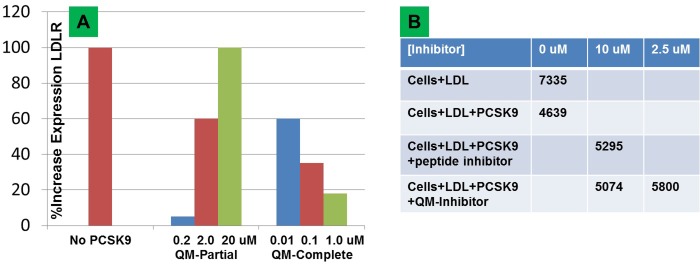
PCSK9 cellular assays.Addition of PCSK9 to HepG cells causes LDLR internalization. LDLR cell surface expression (A) is normalized by assigning 0% and 100% to the experiment with added and no PCSK9 respectively. Using this scale, the compound with the partial QM linker has an EC50 between 0.2–2.0 μM with a typical dose-response curve. The compound with a delocalization linker has an EC50 < 10 nM with an aberrant inverse dose-response curve (observed with anti-cancer agents, see discussion) due to π-π stacking. We tested the compound with a linker that supports delocalization (B) in fluorescently labeled LDL uptake assays with HepG cells. When the compound blocks PCSK9, more LDL particles are internalized inside the cells and the fluorescence remains after a wash. We used a peptide inhibitor known to block PCSK9 with 1 μM affinity as a positive control. The fluorescence of the cells after application of labeled LDL is 7335, but reduced to 4639 with application of PCSK9 and partially restored to 5295 when 10 μM of peptide is added. The complete inhibitor shows inverse dose-response in this assay also, becoming dramatically more potent when lowering the concentration from 10 μM to 2.5 μM. Japan Tobacco obtained almost identical results upon repeating the assays several times and so supplied us with the average values. We repeated our experiments six times and obtained very similar results in all cases.